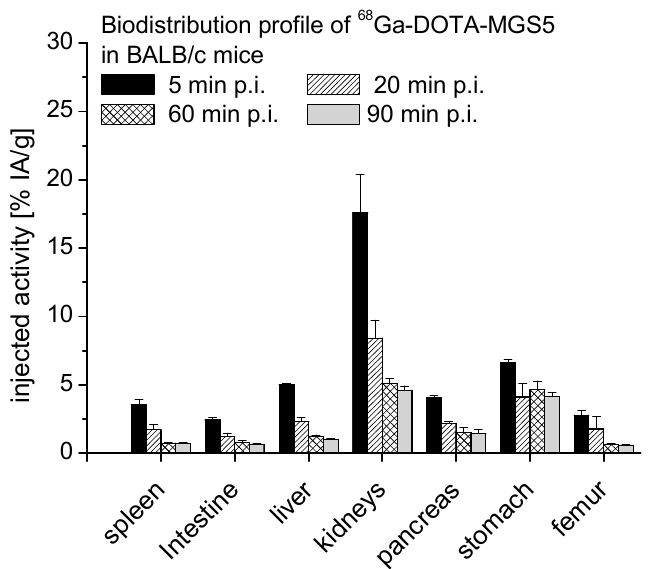
Figure 7. Biodistribution of 68 Ga-DOTA-MGS5 in BALB/c mice at 5, 20, 60, and 90 min p.i. ( n = 12). Table 3. Uptake values obtained from biodistribution studies with 68 Ga-DOTA-MGS5 (0.2–0.5 MBq, 20 pmol peptide) at 5, 20, 60, and 90 min p.i. in female BALB/c mice; values expressed as % IA/g (mean ± SD, n = 3). 68